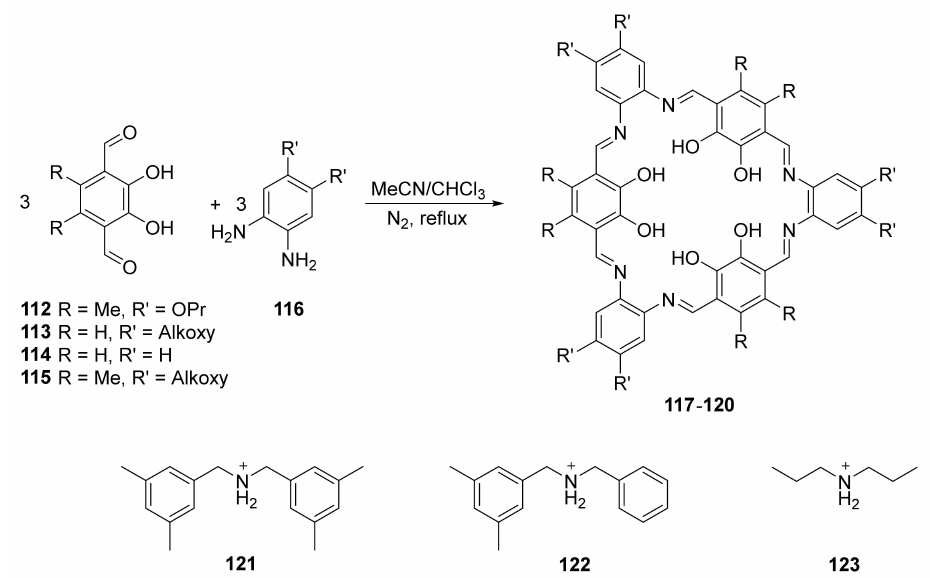
Figure 21. Synthesis of [3 + 3] polymimine macrocycles 117 – 120 and structures of the guest molecules’ secondary amino salts 121 – 123 .